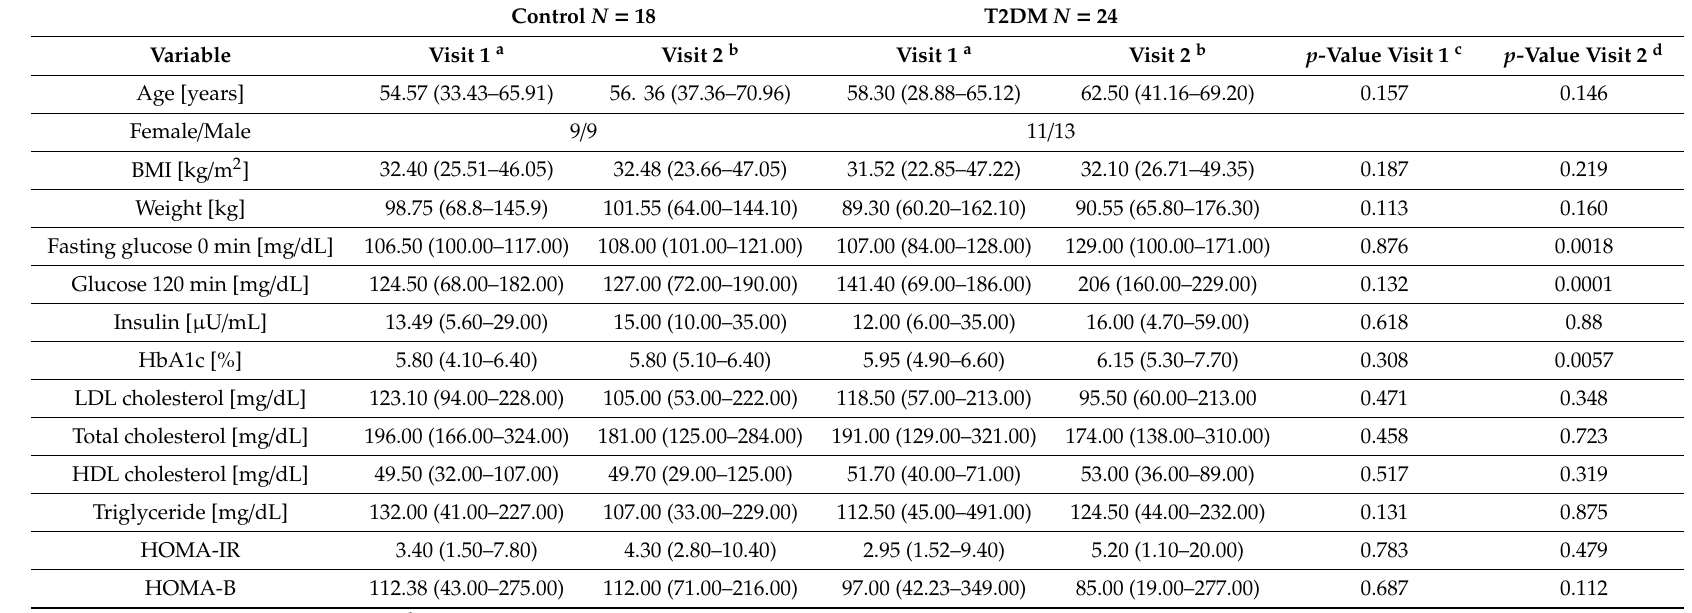
Table 1. Characteristics of the studied group (median and